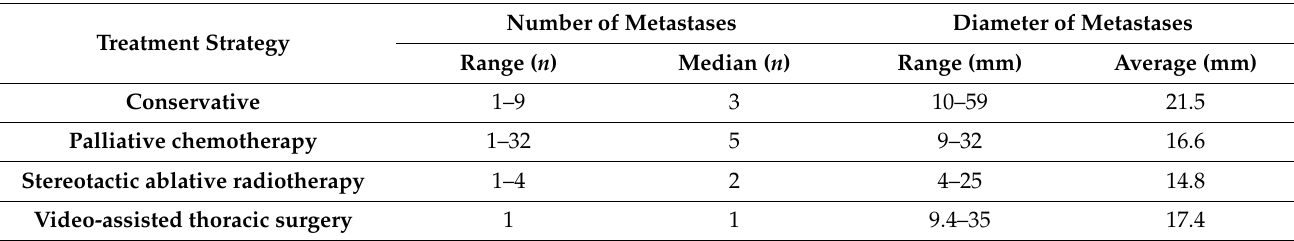
Table 3. Numerical and dimensional characteristics of the lung metastases .